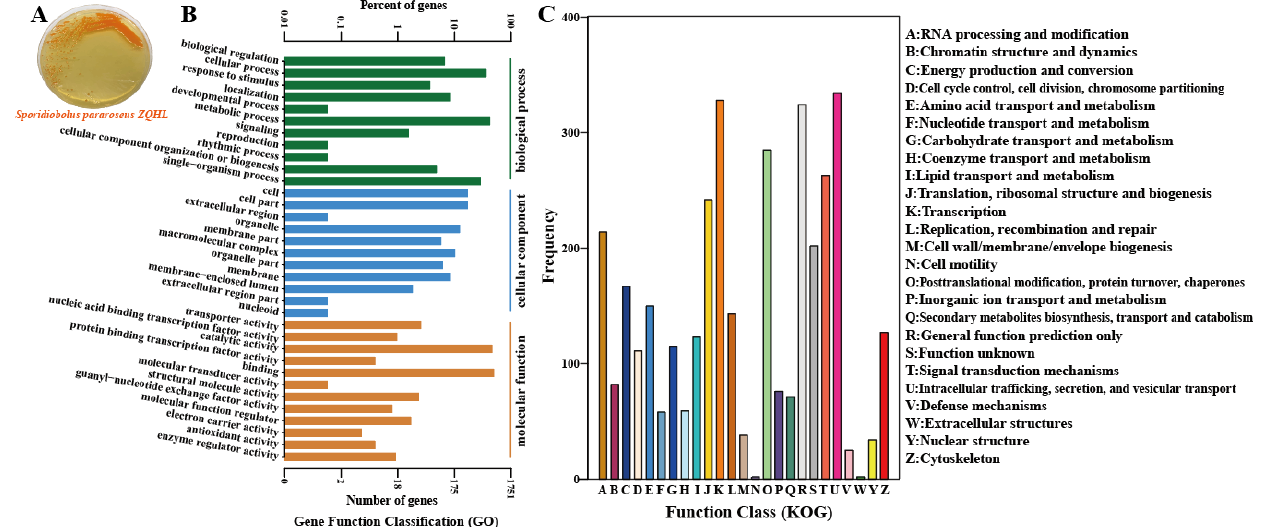
Figure 2. Culture morphology and whole genome sequencing of Sporidiobolus pararoseus ZQHL. ( A ) Culture morphology of S. pararoseus ZQHL. ( B ) Functional annotation of GO of S. pararoseus ZQHL. ( C ) Functional annotation of the COG of S. pararoseus ZQHL.